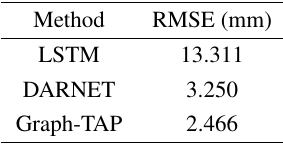
Figure 3. A partial display of the graph we constructed. (a) shows multiple nodes of the knowledge graph, and (b) is the zoom in version of the red part of (a). Table 3. RMSE results of different methods on test sets